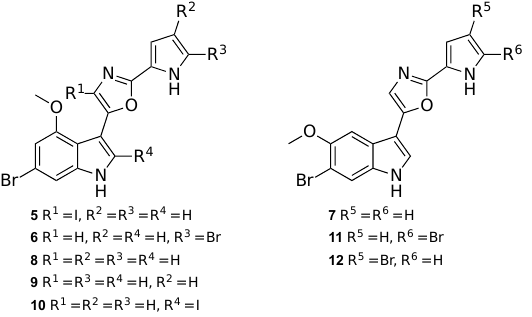
Figure 2. Breitfussins A–H ( 5 – 12 ).